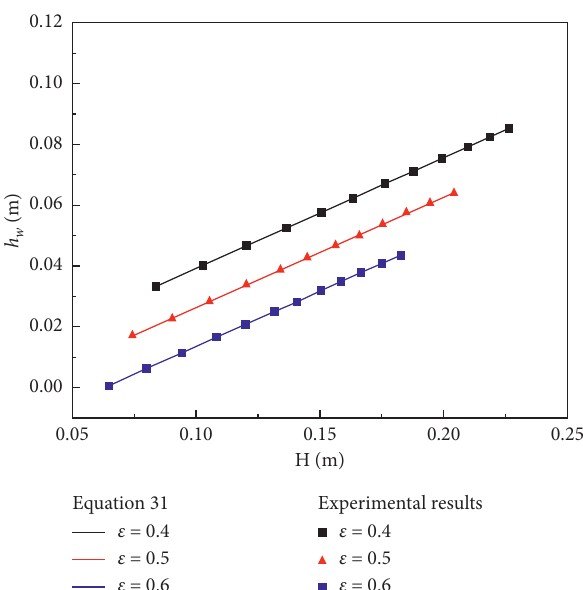
Figure 14: Relationship between the head loss ( h w ) and the upstream water depth (H) at different contraction ratios.